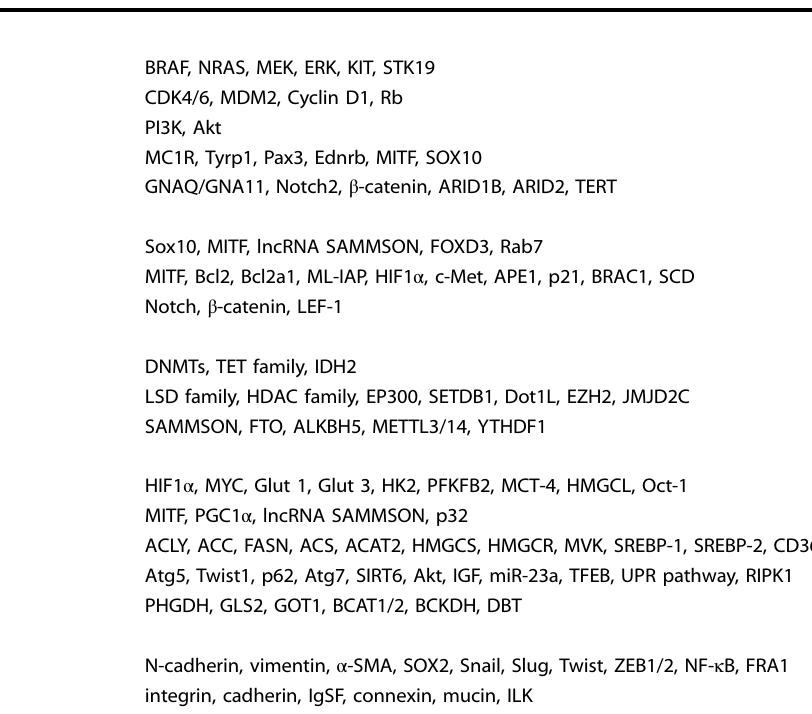
Table 4. Summary of signaling pathways and potential therapeutic targets in the present